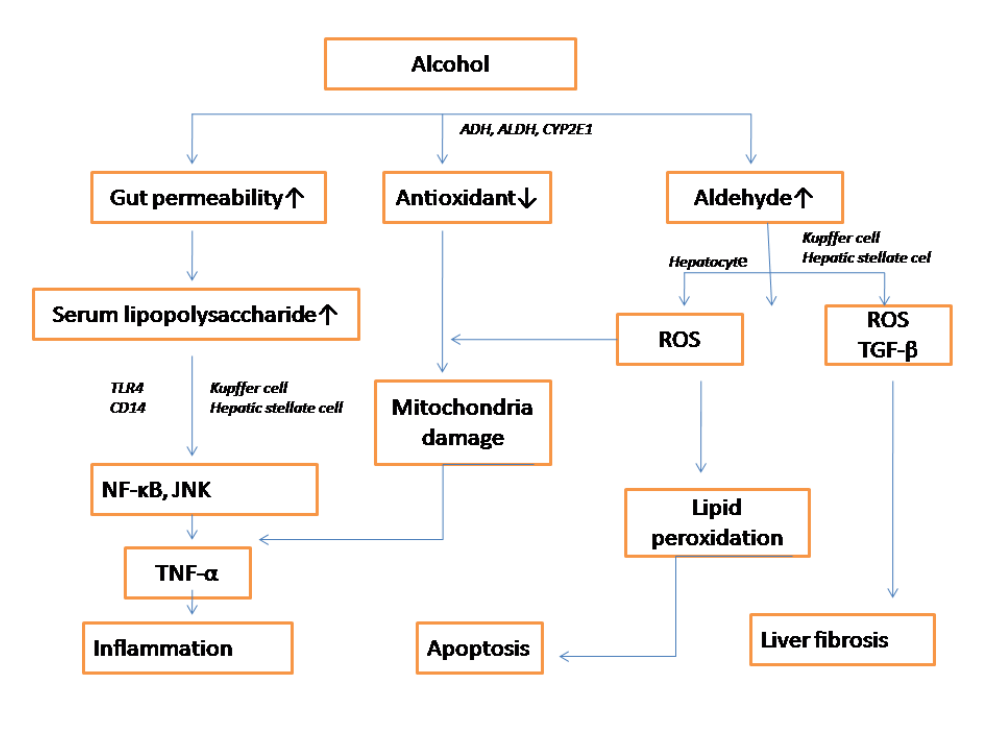
Figur e 2. The pathogenesi s of AFL D